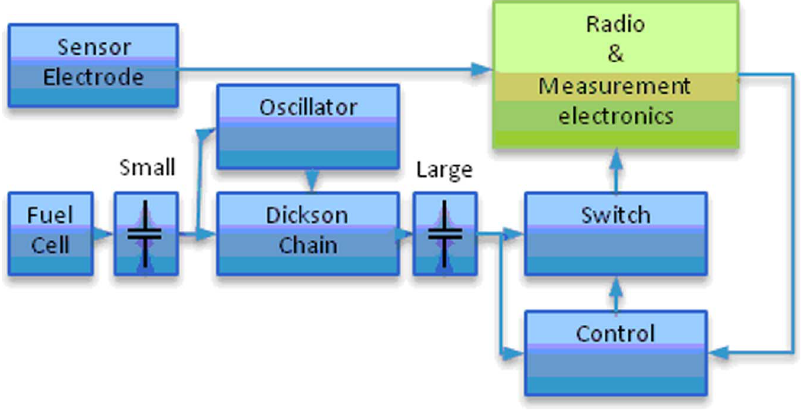
Figure 1. Charge pump design. Overall scheme of the charge pump design divided into different modules connected to electronics for sensing, sampling, and wireless radio transmission of data.